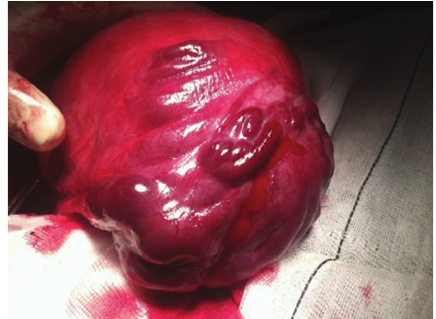
Figure 1: A bleeding uterine superficial varicocele of about 7cm was found on the left uterine horn.